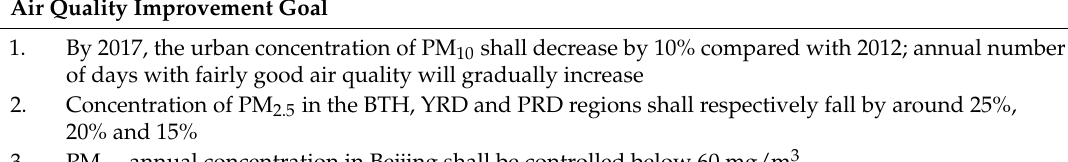
Table 2. China National Action Plan on Air Pollution Prevention and Control (2013–2017) 1